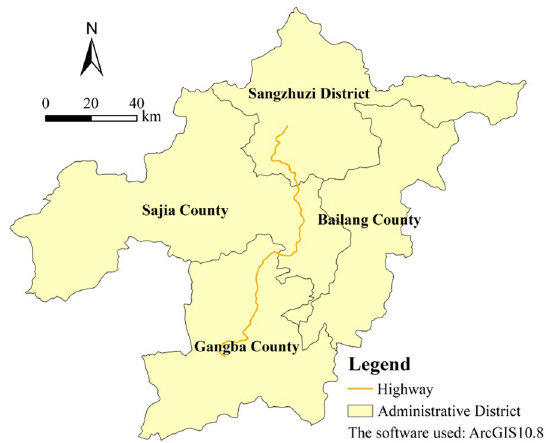
Figure 1. Location of the highway section from Qumei to Gamba.